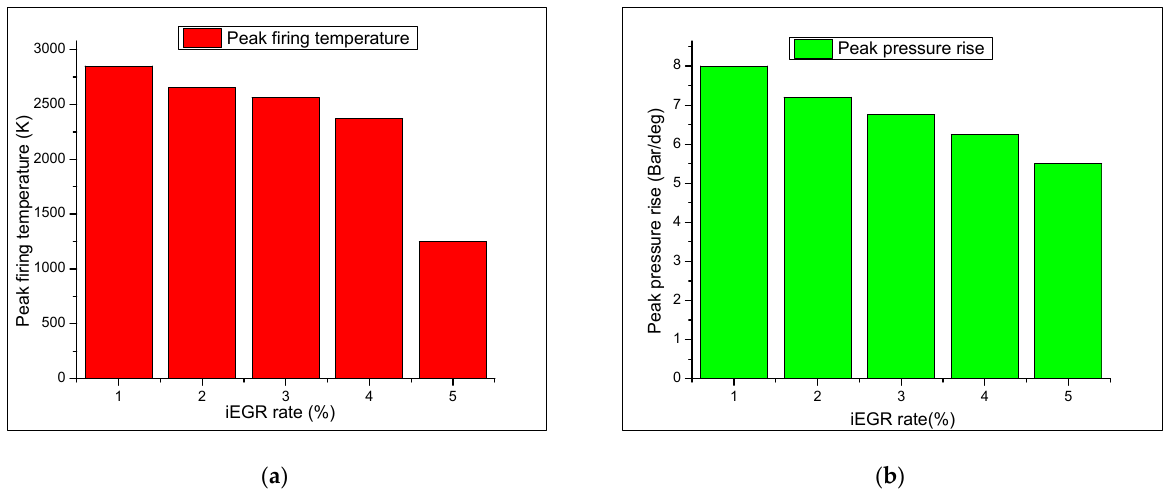
Figure 14. The Effect of iEGR on: ( a ) Peak firing temperature; ( b ) peak firing pressure. In a combustion stroke, the chemical energy trapped in the cylinder is released as heat. A certain amount of heat energy is lost through heat transfer, pumping loss, and energy that is not effectively released in the cylinder (but instead goes into the combustion products). The remaining energy is the effective release energy. A decrease in effective release energy (Figure 15a) with an increase in residual exhaust gas was observed. To increase thermal efficiency, a short burn time can lead to a faster release of heat energy. However, the increase in residual gas in the cylinder due to a longer burn time, lower peak firing pressure rise, and lower peak firing temperature reduces the effective release energy. The effective release energy decreased from 0.85 KJ to 0.53 KJ when the iEGR increased from 1% to 5%.